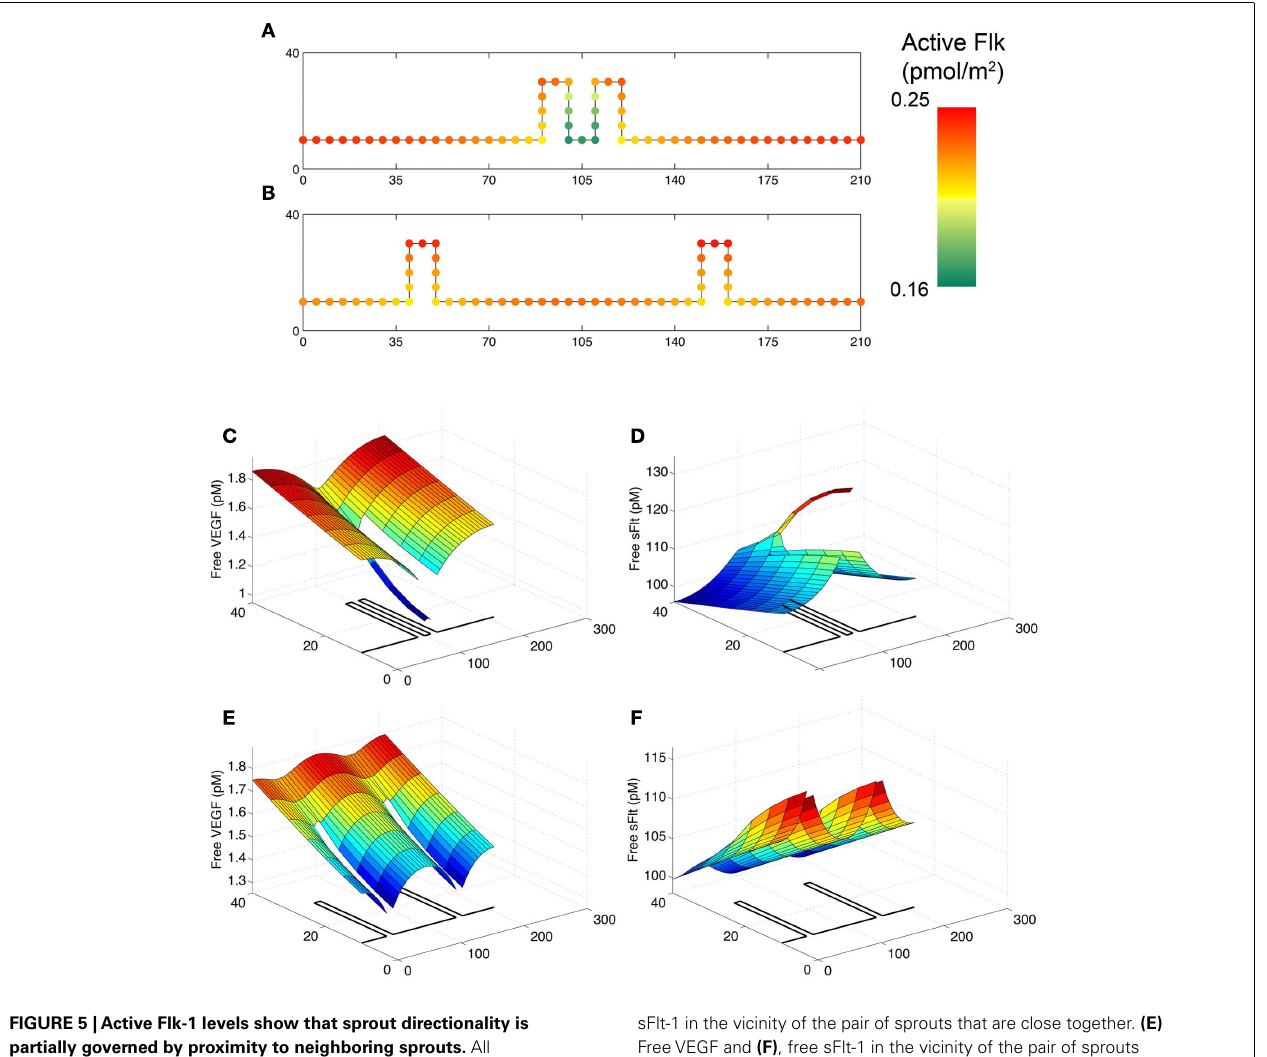
FIGURE 5 |Active Flk-1 levels show that sprout directionality is partially governed by proximity to neighboring sprouts. All panels are for the scenario with both base and sprout sFlt-1 secretion. (A,B) Active Flk-1 levels on sprouts that are closer to (A) or farther away from (B) each other. (C) FreeVEGF and (D) , free